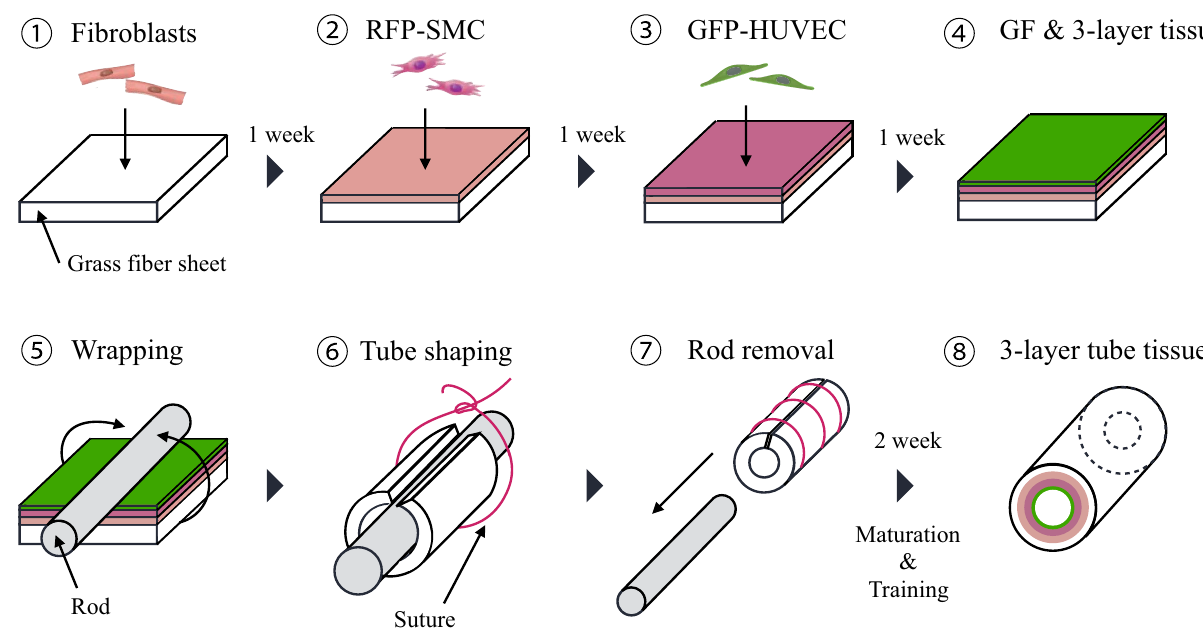
Figure 13. Construction method of three-layer blood vessel using glass fiber as a scaffold. (1) Fibroblast seeding. (2) Smooth muscle cell seeding on top of fibroblast layer. (3) Endothelial cells seeding onto two-layer smooth muscle cells/fibroblast structure. (4) Layer structure conditioning and tissue maturation. (5) Wrapping the flat sheet around the metal rod to form tubular shape. (6) Holding the tube shape with surgical suture. (7) Rod removal/central channel formation. (8) Formed three-layer blood vessel before tissue maturation and